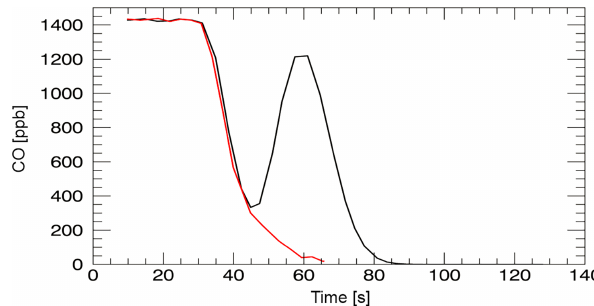
Figure 4. Zoomed in image of CO measurements from the flight on 25 May 2016. After switching the two position valves to mea- surement mode. Before switching, the analyser measures the high CO mixing ratios of the PG, then a decrease in CO is observed, representing the low CO values of the Cal gas used for flushing the transfer lines, and finally the CO peak from the remaining FG is measured (note that PG and FG are taken from the same gas cylin- der and thus have identical mixing ratios). After the remaining PG has passed the analyser, the CO values drop to the expected low- stratospheric CO values. The red line shows the CO values mea- sured using the same set-up but analysing an AirCore filled with CO-free nitrogen. The area between the black CO peak and the red baseline represents the amount of FG left in the